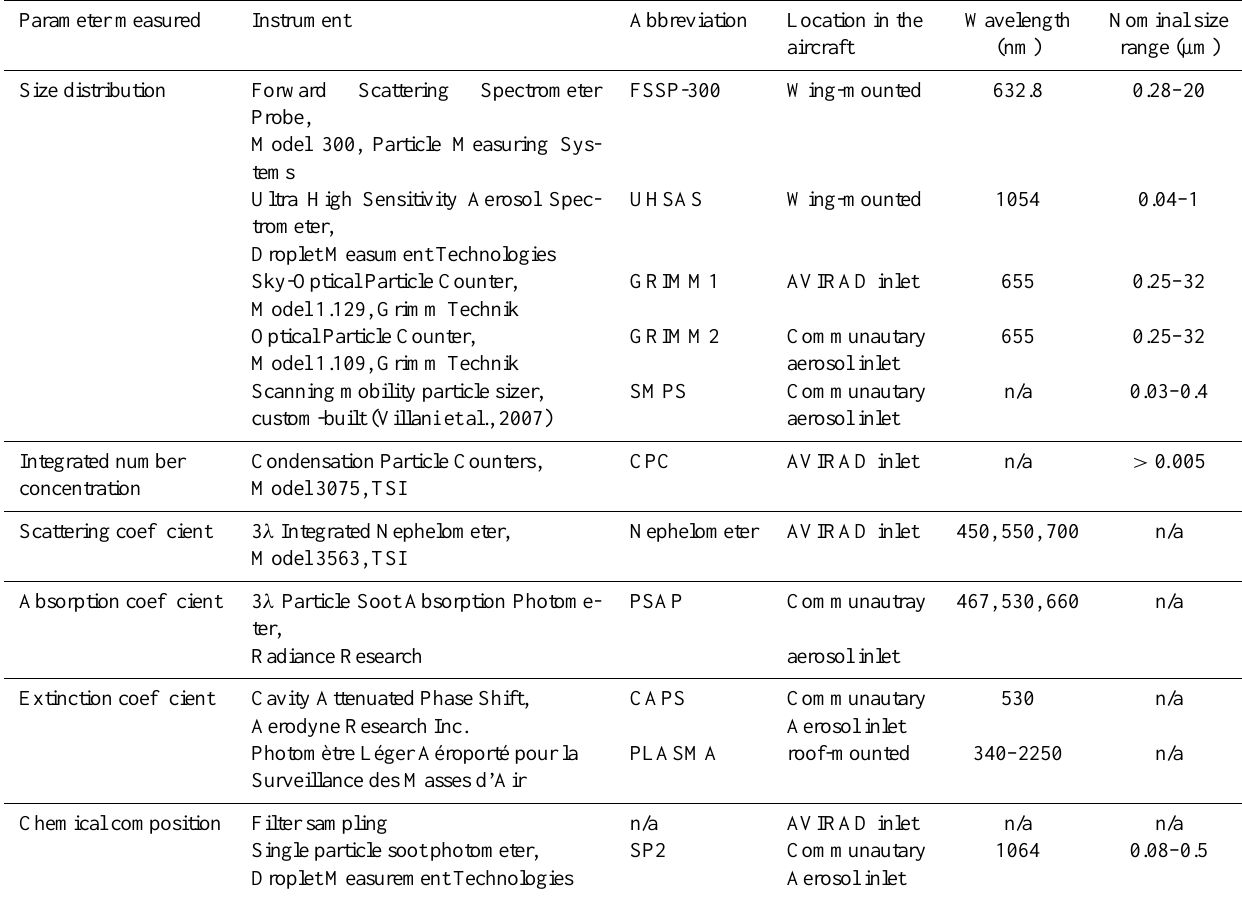
Table 3. In situ instrumentation deployed onboard the ATR-42 during the SOP-1a experiment. Parameter